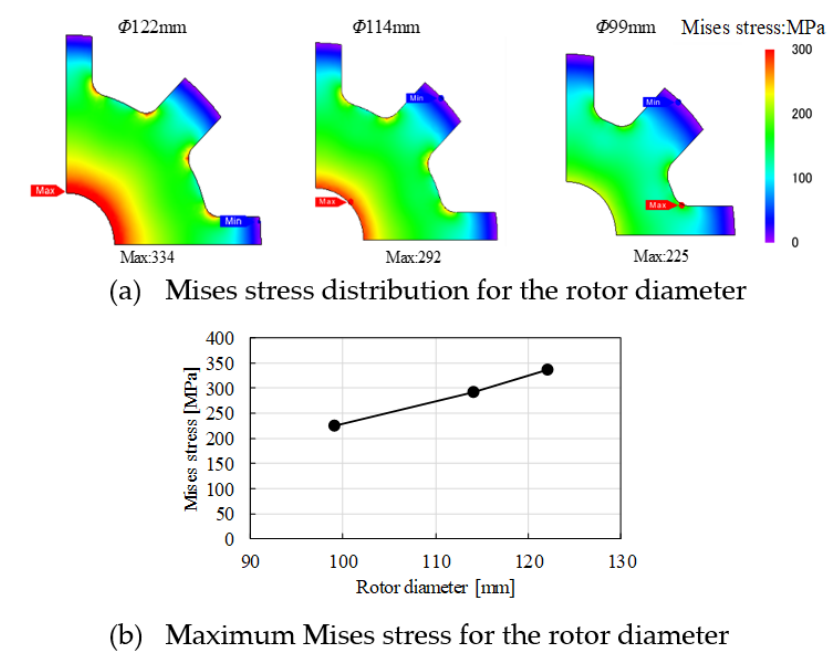
Figure 11. Mises stress of SRM in the rotor at 52,000 min − 1 .